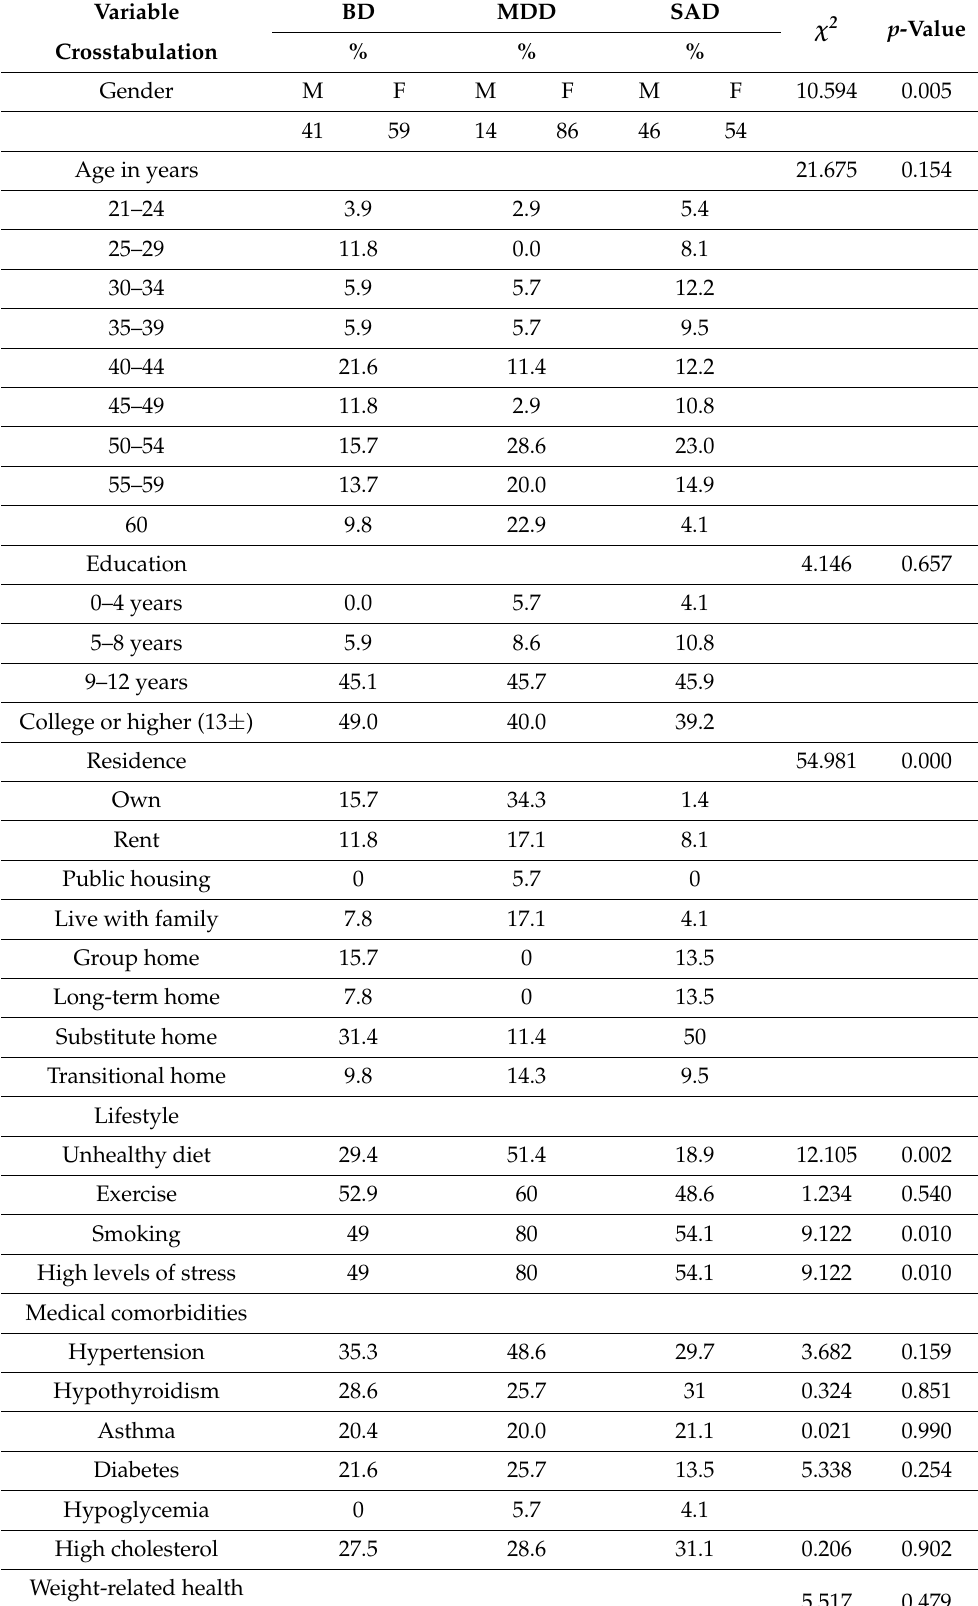
Table 1. Sociodemographic characteristics and mental/physical health